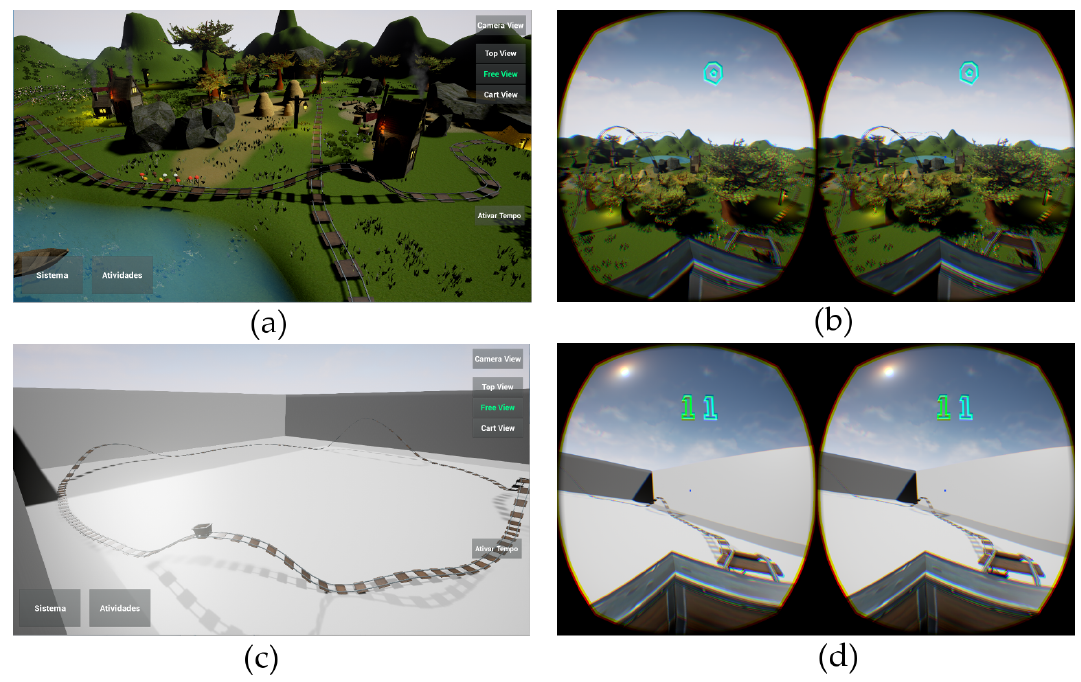
Figure 3. The top and lower images depict the two scenarios, the images on the left are the therapist’s views, whereas the ones on the right are the patient’s views through the Oculus Rift. ( a ) Therapist’s view of Medieval scenario; ( b ) Patient’s view of Medieval scenario; ( c ) Therapist’s view of Thebox scenario; ( d ) Patient’s view of Thebox scenario. While the Medieval scenario is a very colorful and detailed environment, to stimulate vision, Thebox has almost no details, to reduce visual